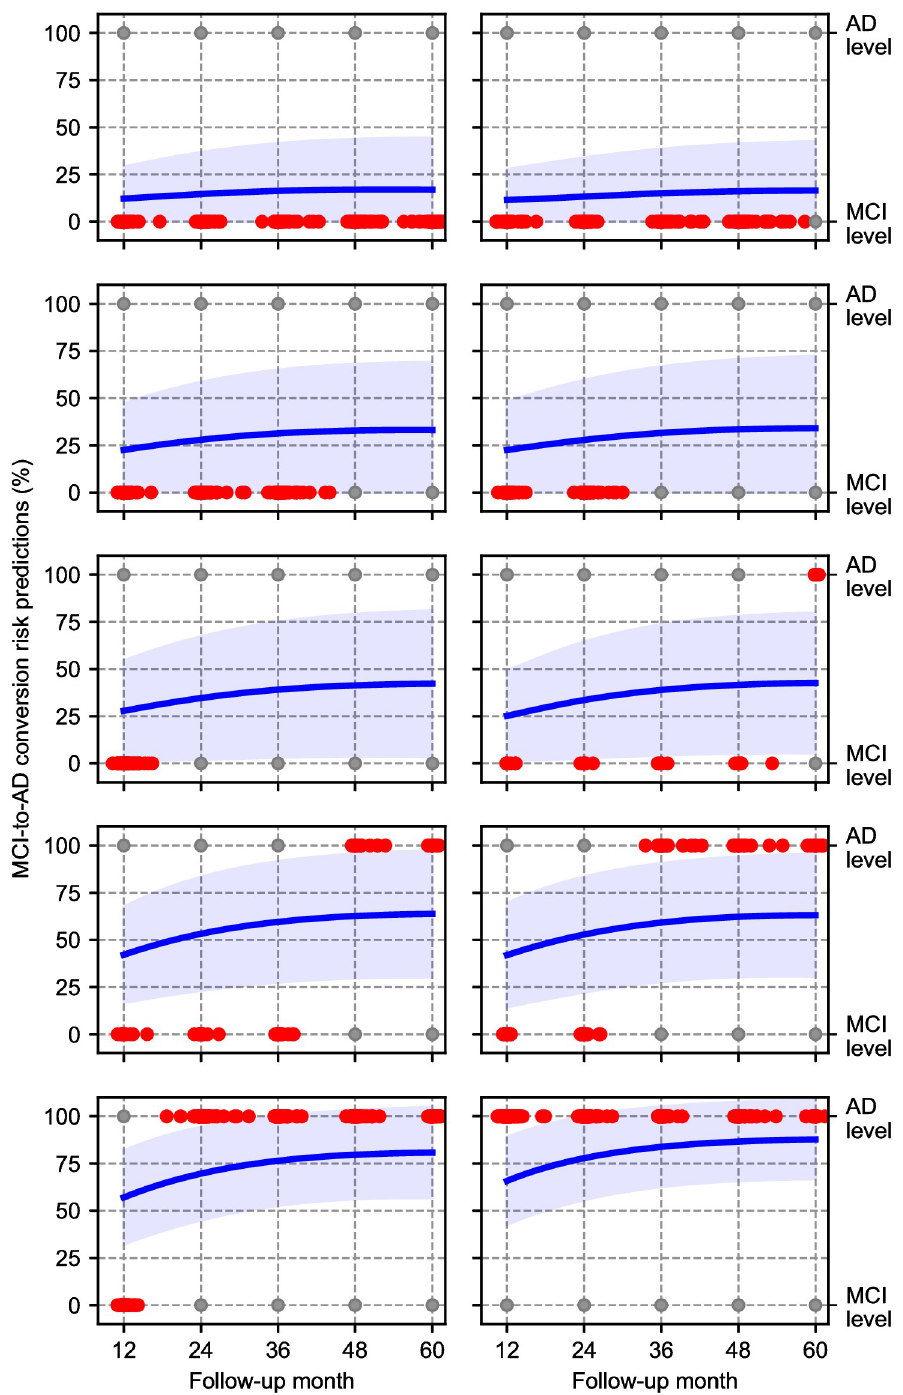
Fig 6. Conversion risk predictions of NMM for MCI baseline participants with different ground truth disease trajectories. Blue line is the average AD conversion risk with 68% confidence. Red dots represent the observed diagnosis time ( x -coordinate) and the observed diagnosis ( y -coordinate) of the participants with the corresponding trajectory. Grey dots are for reference.